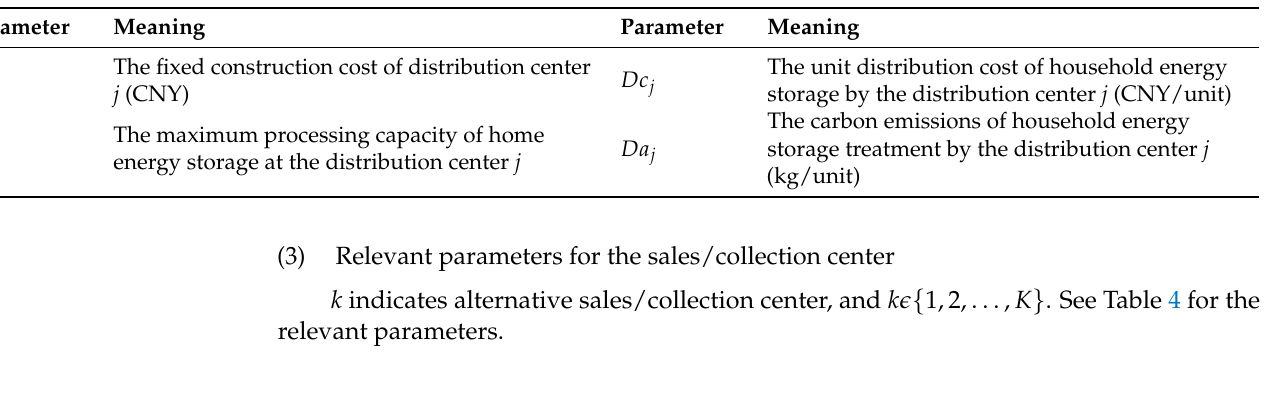
Table 3. Relevant parameters of the distribution